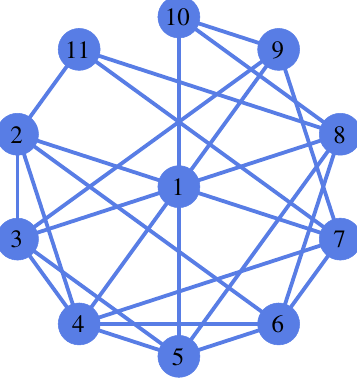
FIG. 3. For this 11-vertex graph, one obtains ϑ( G ) = 4 [48] and, hence, a lower bound of 4 for the minimal dimension. In contrast, our PPT relaxation of Eq. (40) can already exclude both real and complex orthonormal representations in dimension 4.